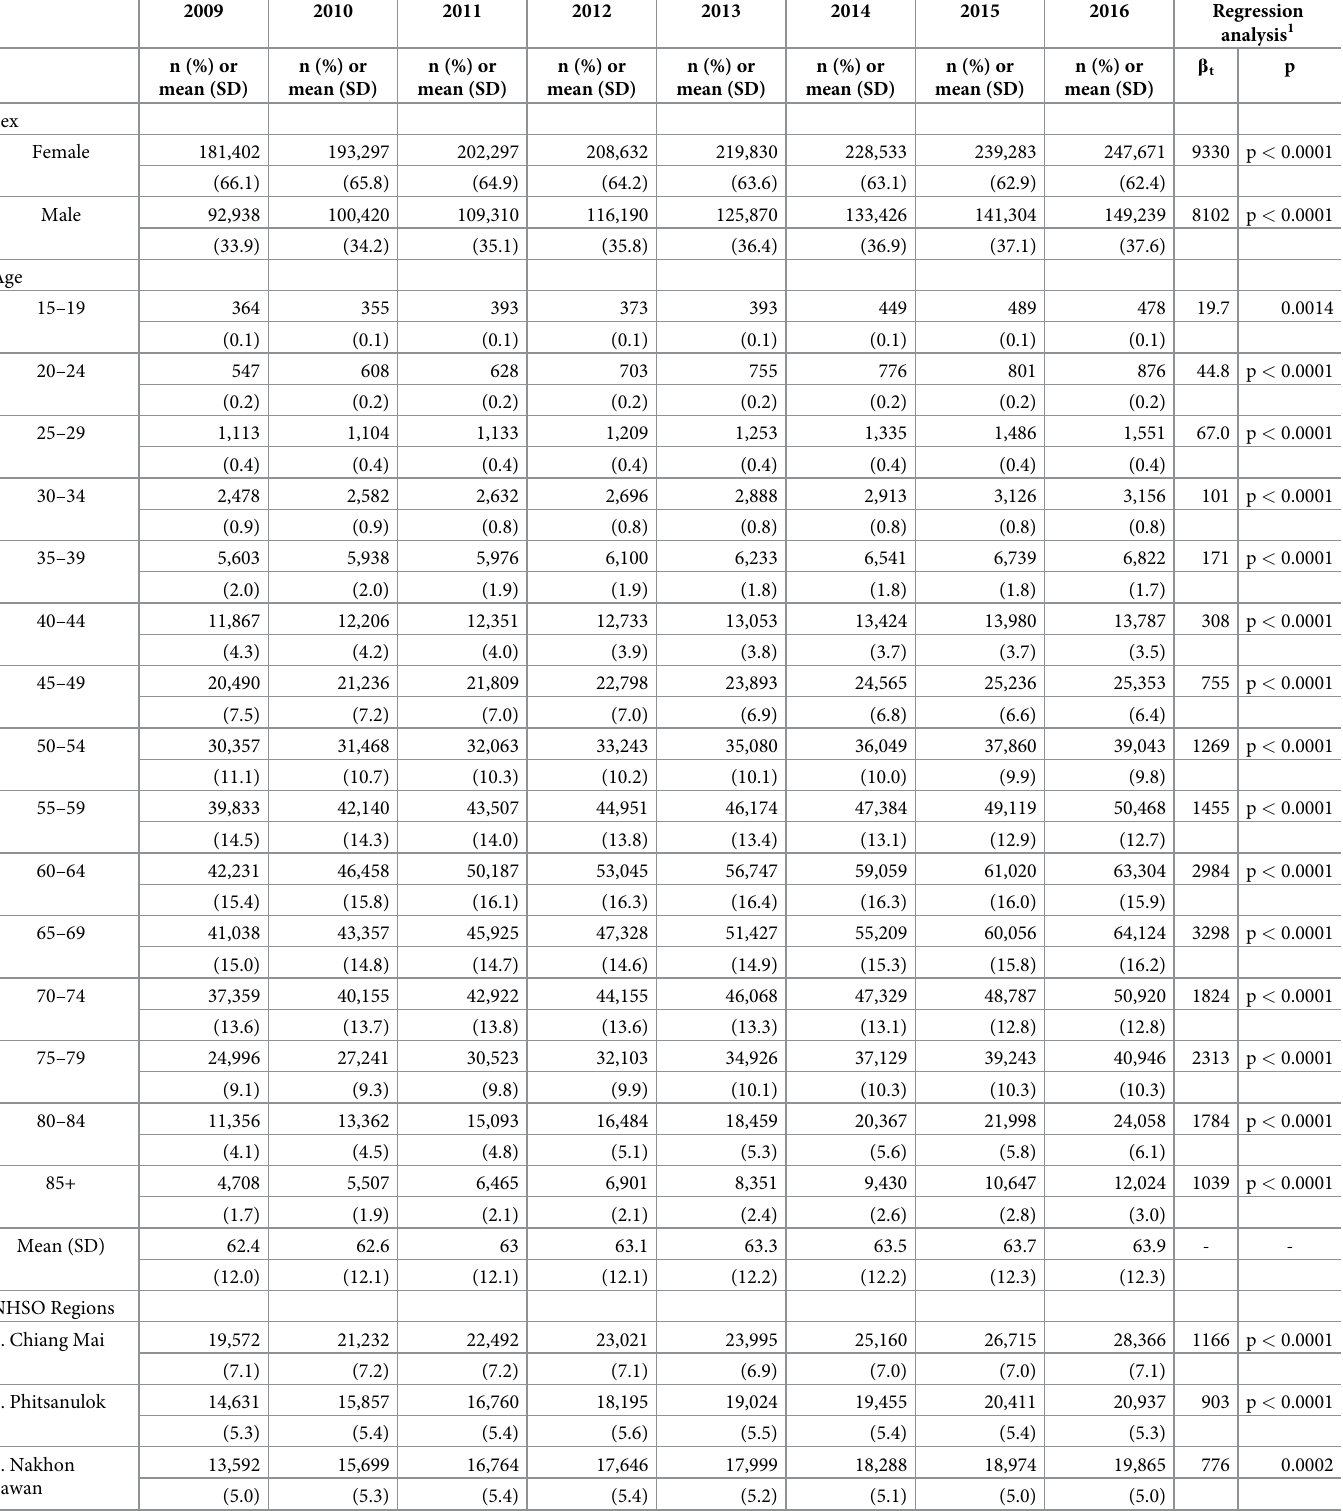
Table 1. Number and demographic characteristics of the Universal Coverage Scheme patients admitted for type 2 diabetes mellitus in